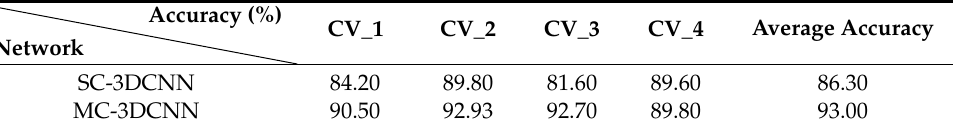
Table 6. Recognition results for di ff erent